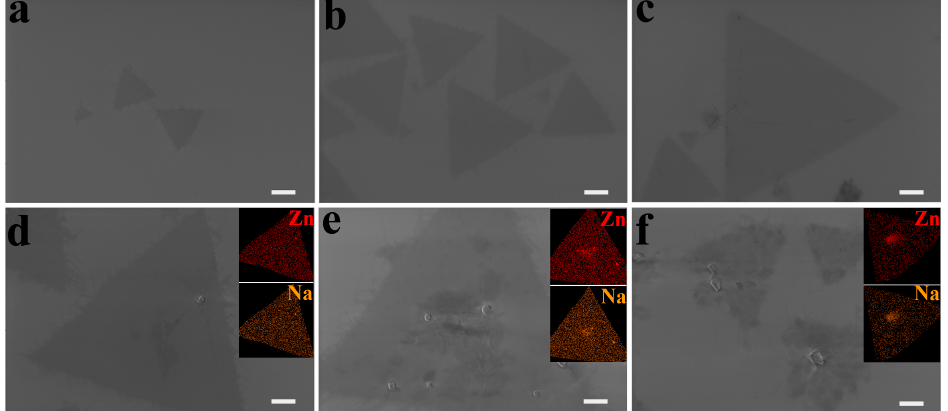
Figure 3. Controlling the growth of 2D ZnO by precursor concentration. SEM images of 2D ZnO synthesized with precursor concentration of ( a ) 40 mM, ( b ) 45 mM, ( c ) 50 mM, ( d – f ) 55 mM, 60 mM and 65 mM. Insets are the corresponding EDS mapping images of Zn and Na elements. Scale bar is 1 μ m.